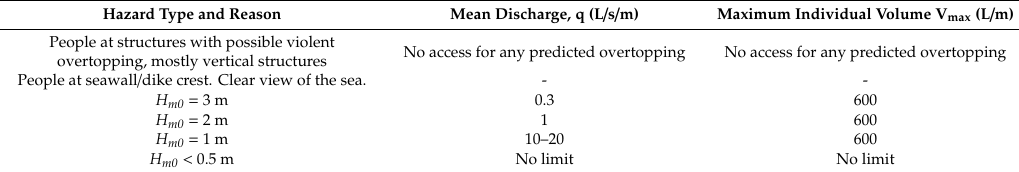
Table 1. Tolerable overtopping limits for people proposed in EurOtop (2018). Hazard Type and Reason Mean Discharge, q (L / s / m) Maximum Individual Volume V max (L / m) People at structures with possible violent overtopping, mostly vertical structures No access for any predicted overtopping No access for any predicted overtopping People at seawall / dike crest. Clear view of the